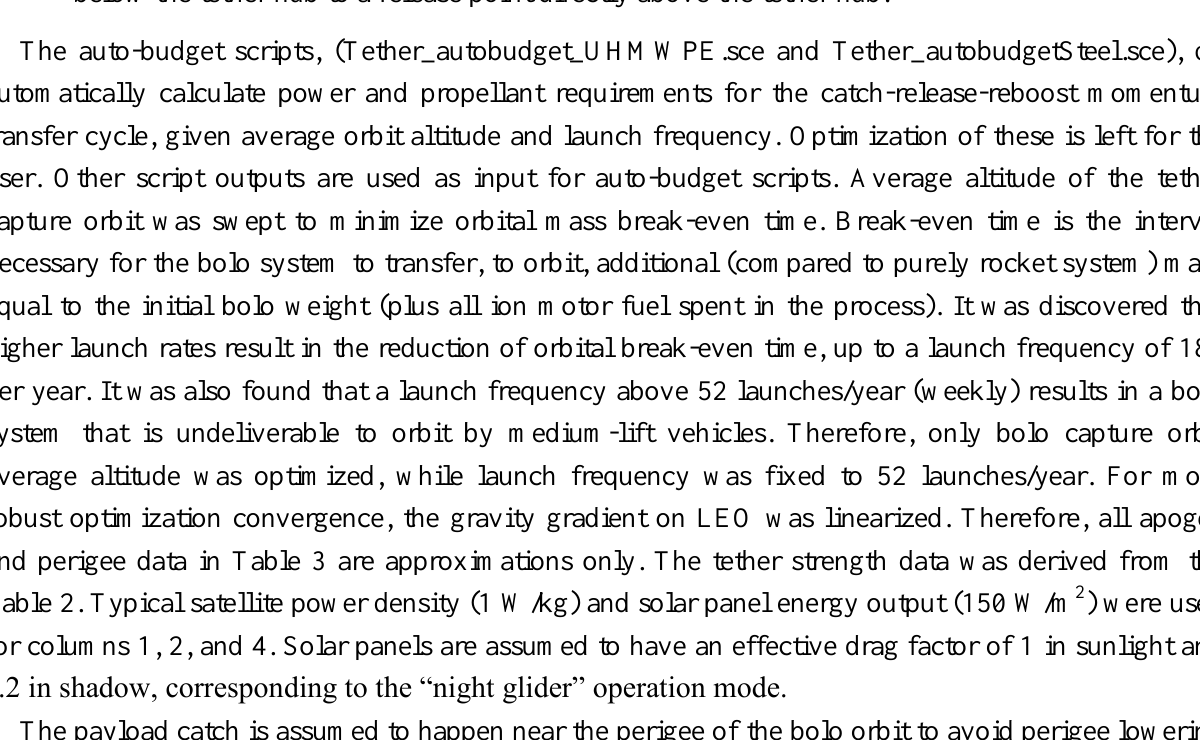
Table 2. Typical satellite power density (1 W/kg) and solar panel energy output (150 W/m 2 ) were used for columns 1, 2, and 4. Solar panels are assumed to have an effective drag factor of 1 in sunlight and 0.2 in shadow, corresponding to the ―night glider‖ operation